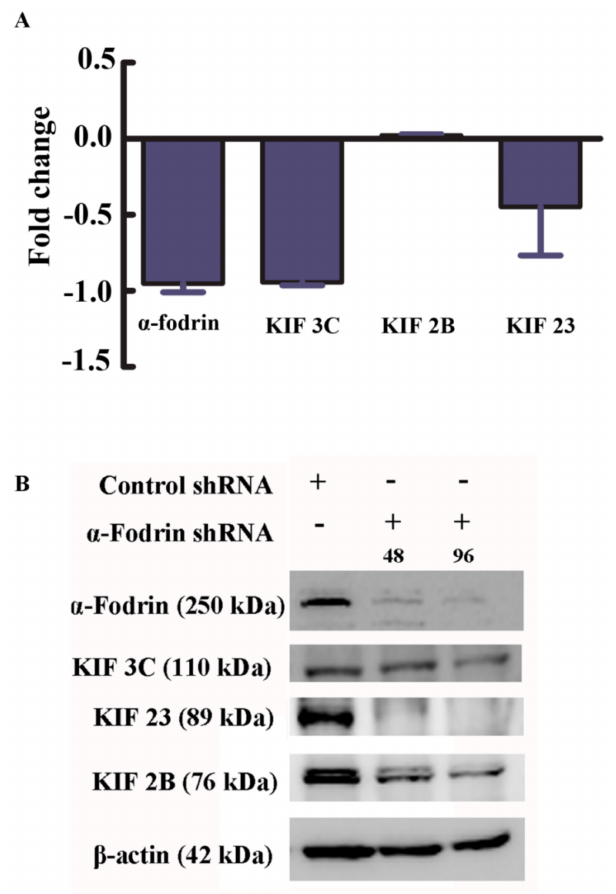
Figure 5. ( A ) Real-time qPCR validation of selected microtubule cytoskeleton-associated genes. Shown is the fold change expression of genes in α -fodrin shRNA-treated U-251 MG cells with respect to control shRNA-treated cells. β -actin is the internal control. ( B ) Western blot results showing the reduction in KIF 3C, KIF23 and KIF 2B upon α -fodrin downregulation post- α -fodrin shRNA treatment for 48 and 96 h. β -actin is used as loading